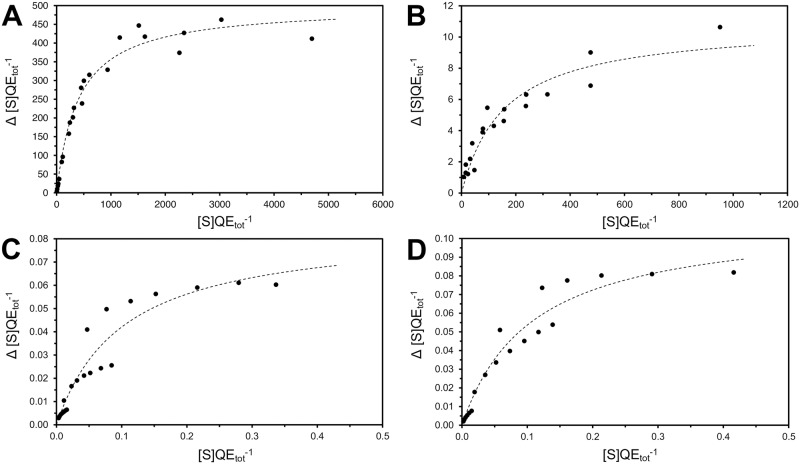
Validity of Eq (10).The online tool WebPlotDigitizer [29] was used to extract data reported in figures. (A) The Invertase from S. cerevisiae immobilized on poly-(ethylene diaminoethylstyrene)-Q beads has a k2 of 500 s-1 and a KM,flow of 402 s-1 [30]. (B) The Transketolase from E. coli immobilized in a NTA derivatised micro-capillary has a k2 of 11 s-1 and a KM,flow of 159 s-1 [31]. (C) Ficin immobilized on CM-cellulose 70 has a k2 of 0.085 s-1 and a KM,flow of 0.101 s-1 [6]. (D) Ficin immobilized on CM-cellulose 90 has a k2 of 0.0111 s-1 and a KM, flow of 0.107 s-1 [6].